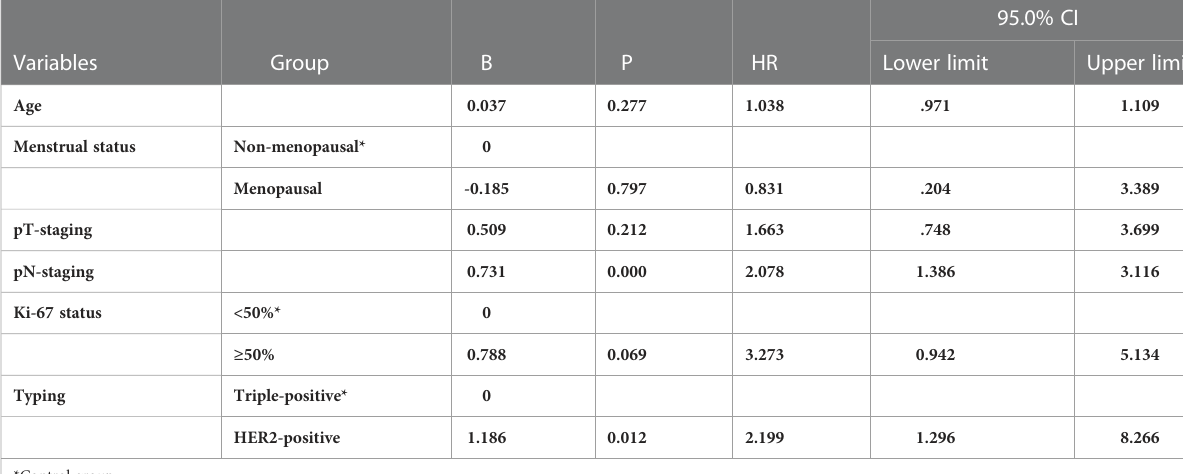
TABLE 8 Multifactorial Cox analysis of 5-year disease-free survival of the 135 breast cancer patients.